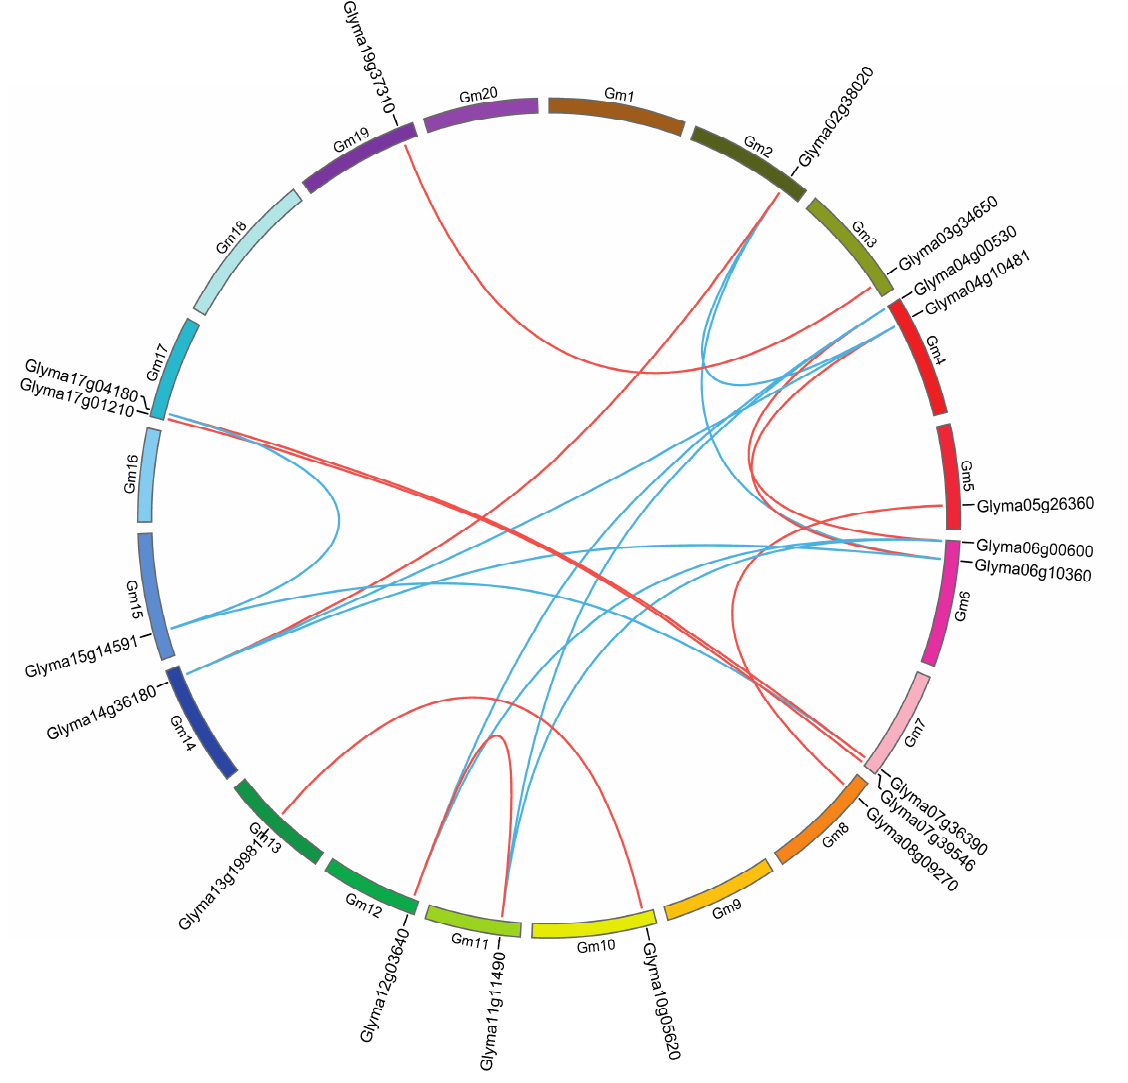
Figure 5. Chromosome locations of HECT genes and segmentally duplicated gene pairs in the soybean genome. Chromosomes 1–20 are shown with different colors and in a circular form. The approximate distribution of each soybean HECT gene is marked on the circle with a short black line. Colored curves denote the details of syntenic regions between soybean HECT genes (Blue and red curves represent the estimated time of duplication events-5–12 Mya (million year ago) and 32–46 Mya,